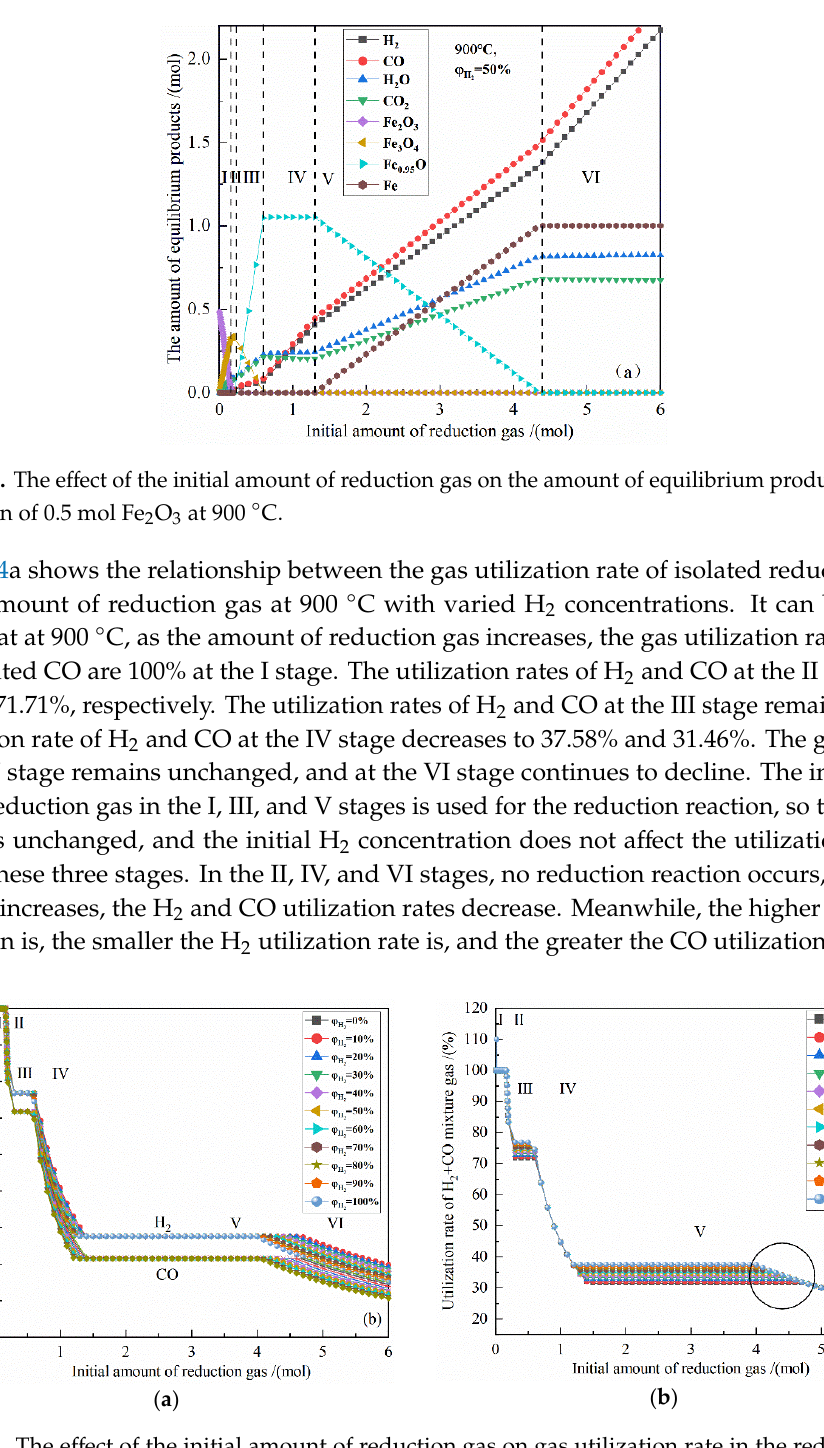
Figure 4. The e ff ect of the initial amount of reduction gas on gas utilization rate in the reduction of 0.5 mol Fe 2 O 3 at 900 ◦ C with varied H 2 concentrations: ( a ) utilization rate of isolated reduction gas; ( b ) utilization rate of H 2 + CO mixture